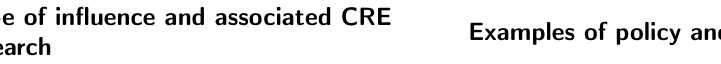
Table 1: Examples of policy and practice influences from our CRE